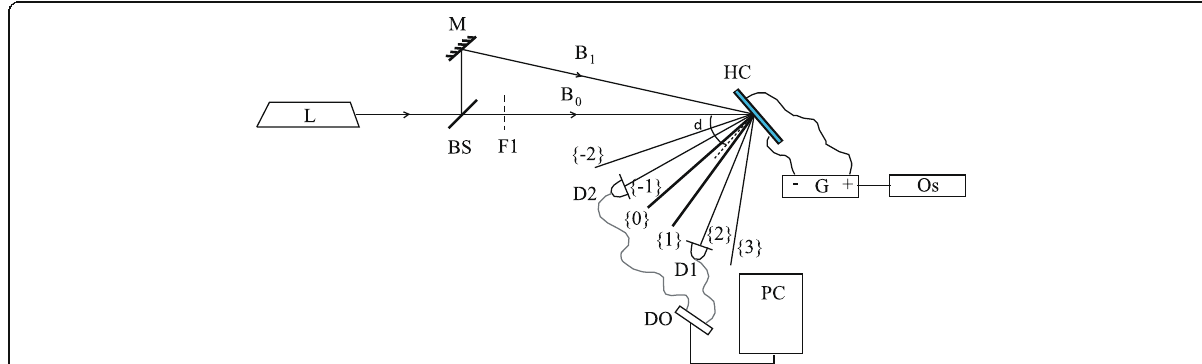
Fig. 3 Scheme of experimental set-up: laser ( L ); mirror ( M ); beam splitter ( BS ); optical filter ( F1 ); beams ( B 0 ) and ( B 1 ); photodiodes ( D1 ) and ( D2 ); hybrid LC cell ( HC ); oscilloscope ( Os ); generator ( G ); digital oscillographe ( DO ); computer ( PC ). The output diffraction orders are {0} and {1} the main orders; { − 1} and {2} the first diffraction orders; { − 2} and {3} the second diffraction orders. δ is the rotation angle of the